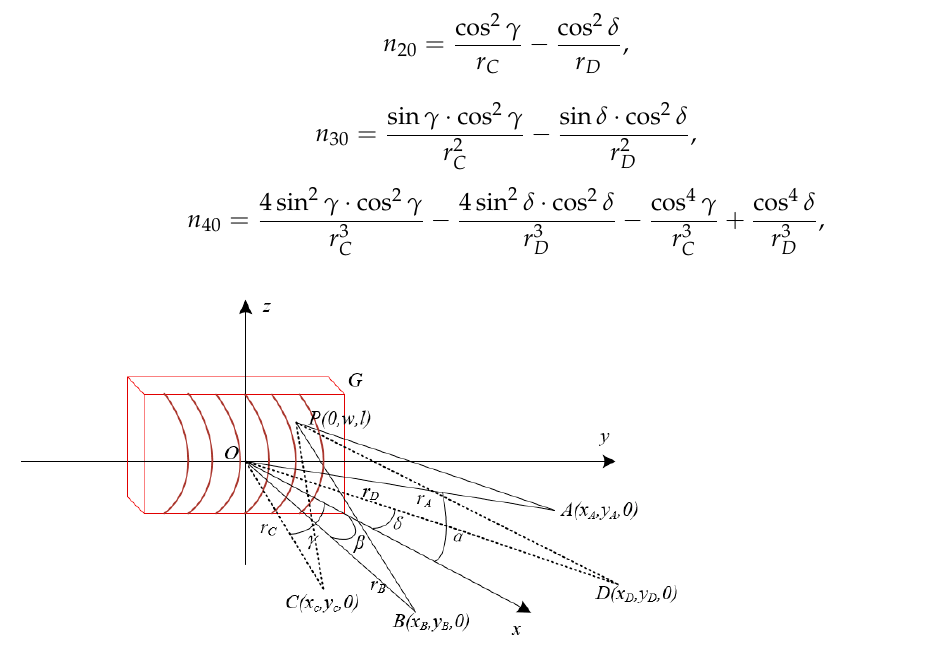
Figure 1. Imaging schematic of aberration axis Fresnel zone plate.